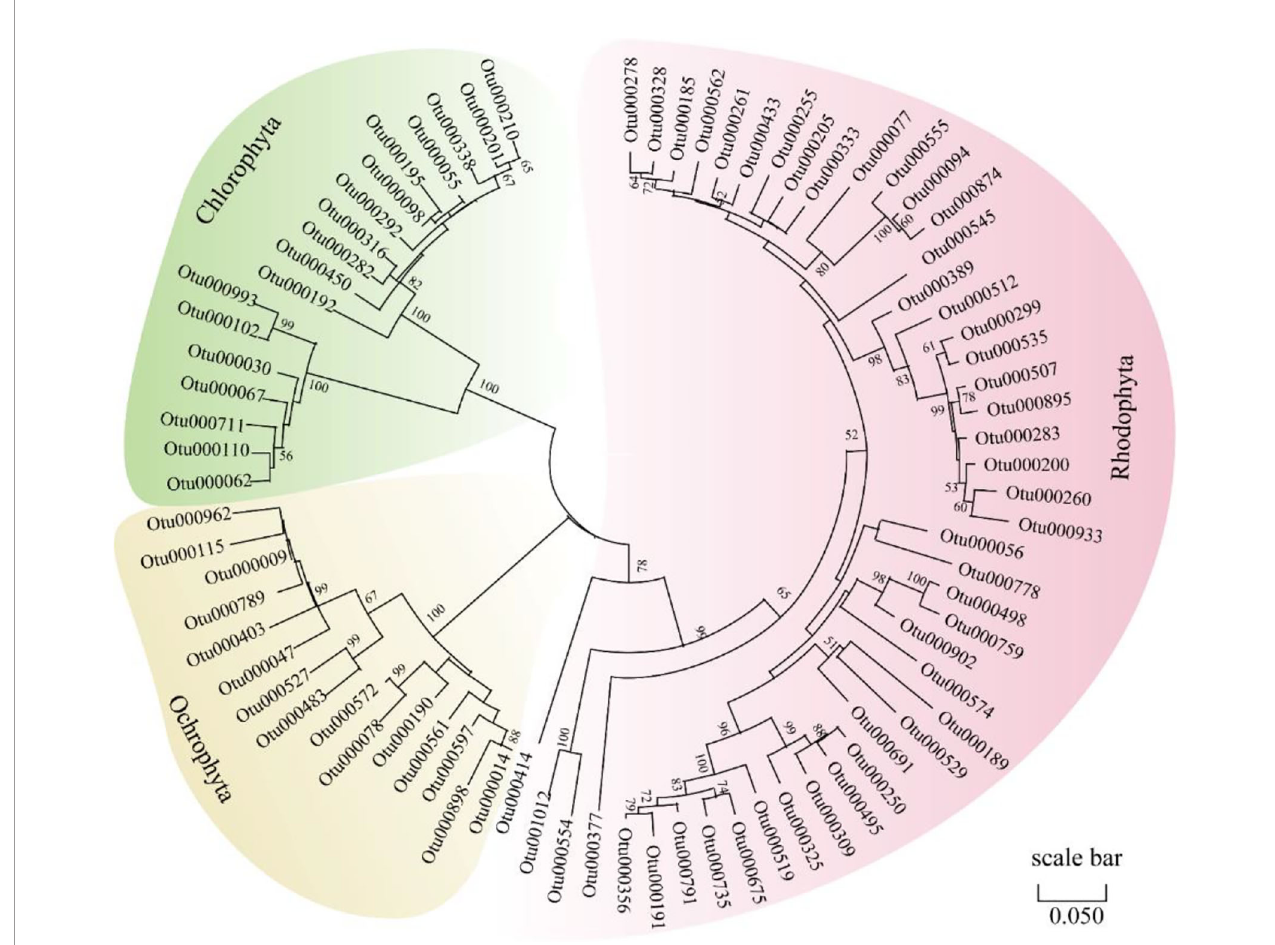
FIGURE 3 | Neighbor-joining tree of 18S rRNA sequences af fi liated to the phyla Chlorophyta, Ochrophyta and Rhodophyta obtained from the intestinal contents of eight coral reef fi sh species which were collected from the Xisha Islands, China. The scale bar represents 5% estimated sequence